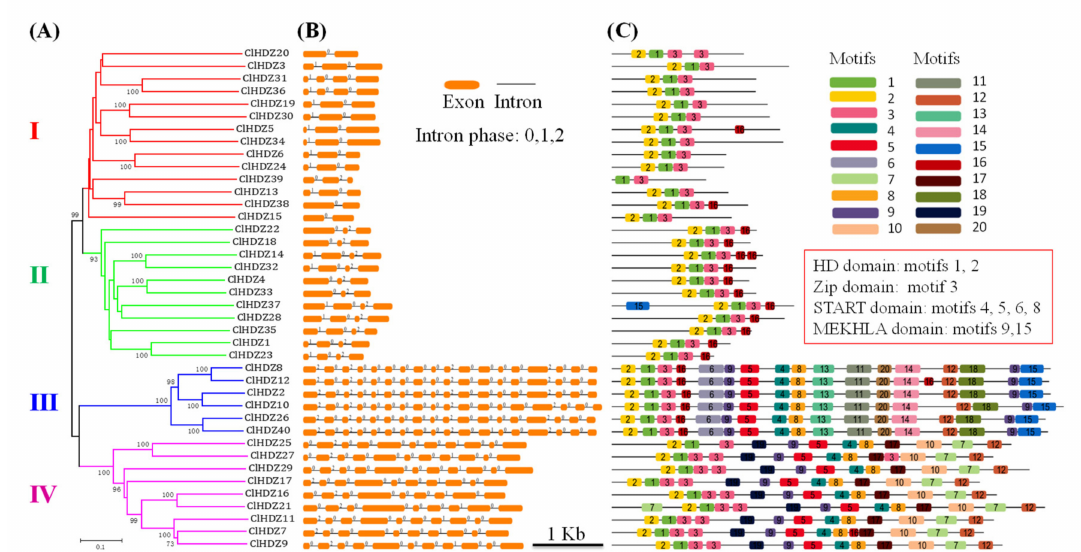
Figure 2. The phylogenetic tree ( A ), gene structure ( B ), and motif distribution ( C ) of ClHDZs . All ClHDZs were divided into the four subfamilies I–IV, and the bootstrap values >65 were shown in the phylogenetic tree. Motifs were marked with different colors and accordingly